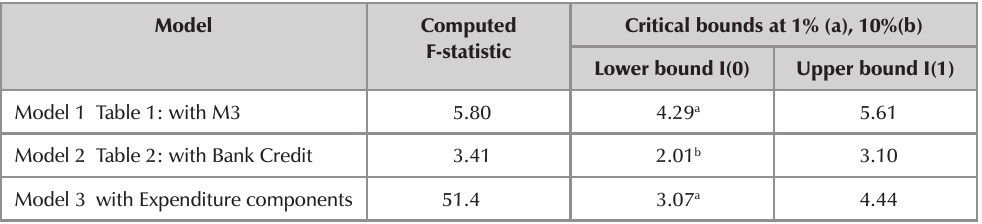
Bounds testing for co-integration analysis Model Computed